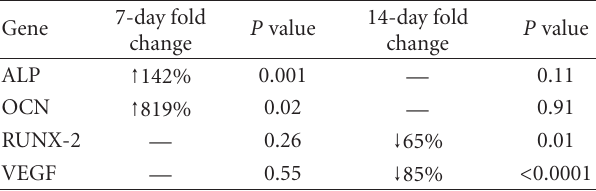
Table 3: Changes in mRNA levels with perfusion flow at 7- and 14-day samples (osteoblast